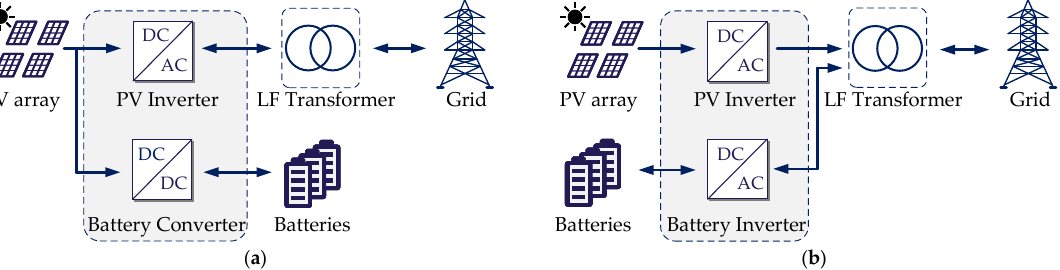
Figure 1. System diagram of the single-stage 1500 V PV system with integrated battery energy storage systems (LF: low-frequency transformer): ( a ) DC-coupled configuration and ( b ) AC-coupled